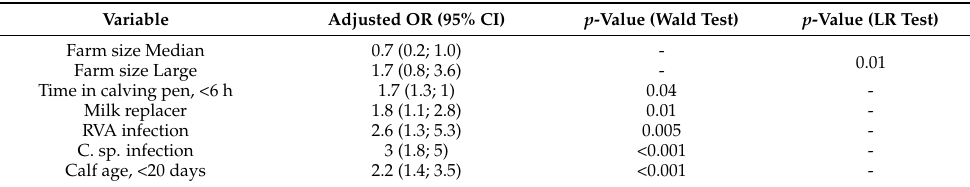
Table 2. Adjusted OD obtained by multiple logistic regression for the independent variable “scours” Log-likelihood = − 277.8; AIC = 571.7.